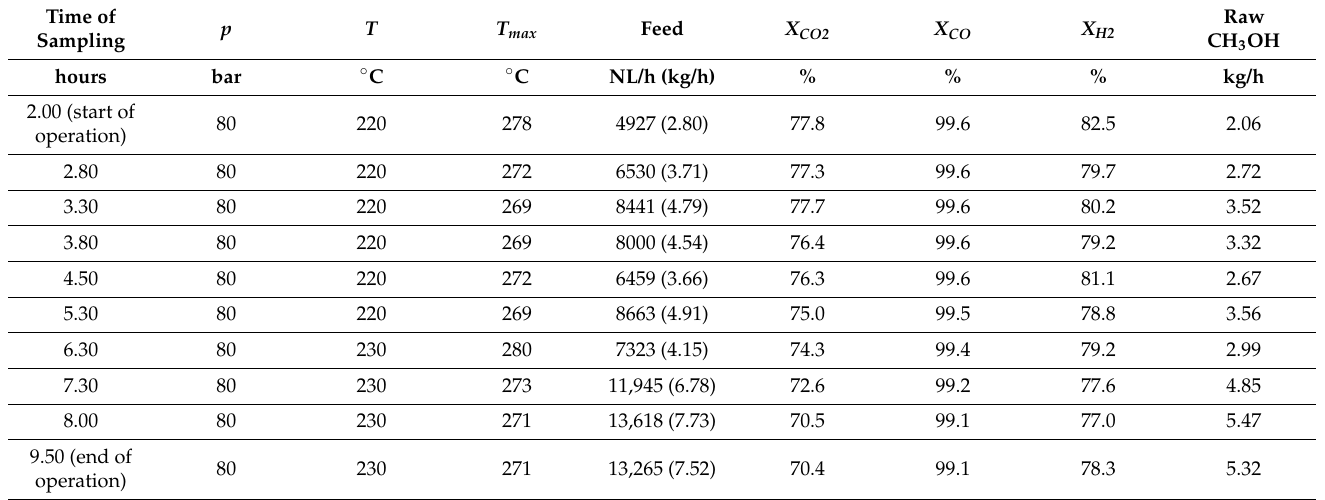
Table 4. SC2. Catalytic performance in the four-stage reactor system ALFE_CH3OH_PLP under once-through conditions.